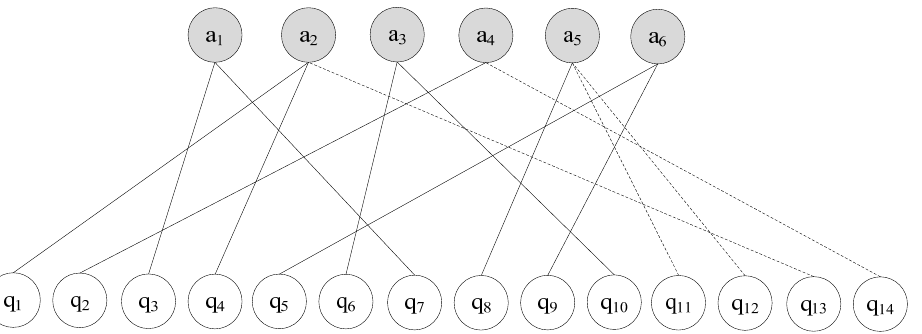
Figure 4. Graph model of the organizational structure of the project team (distribution option 7).